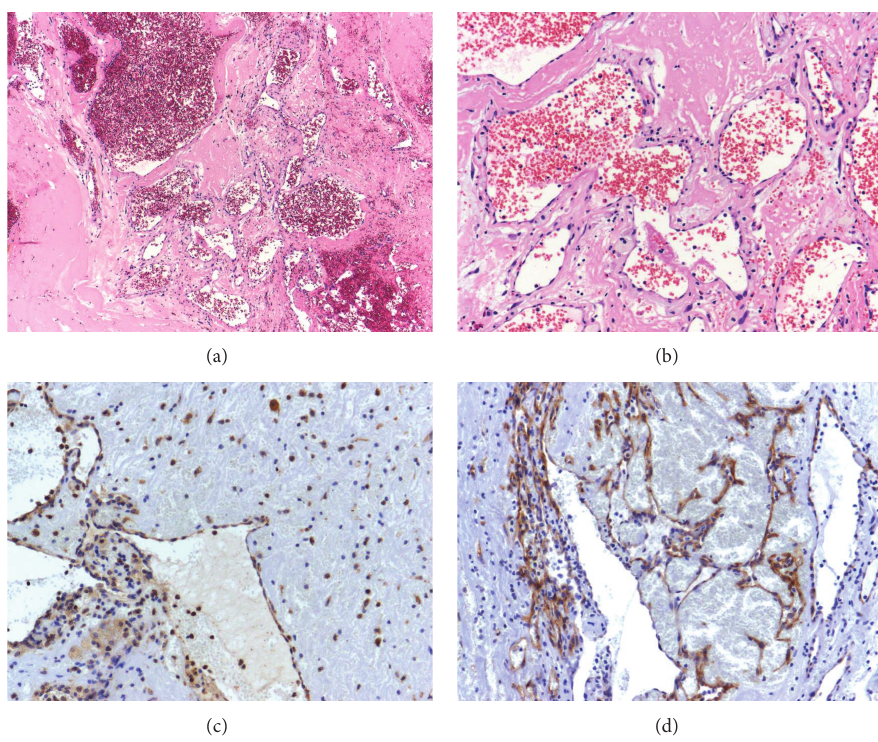
Figure 3: The lesion consisted of dilated vessels, hemorrhage, fibrin, exudation, and fibrosis with hyalinization. Atypical cells are not seen (hematoxylin and eosin staining; (a) original magnification, × 40; (b) original magnification, × 200). VEGF is expressed in endothelial and inflammatory cells around the dilated vessels ((c) original magnification, × 200). VEGFR2 is expressed on the vascular endothelial cells of the dilated vessels ((d) original magnification, ×